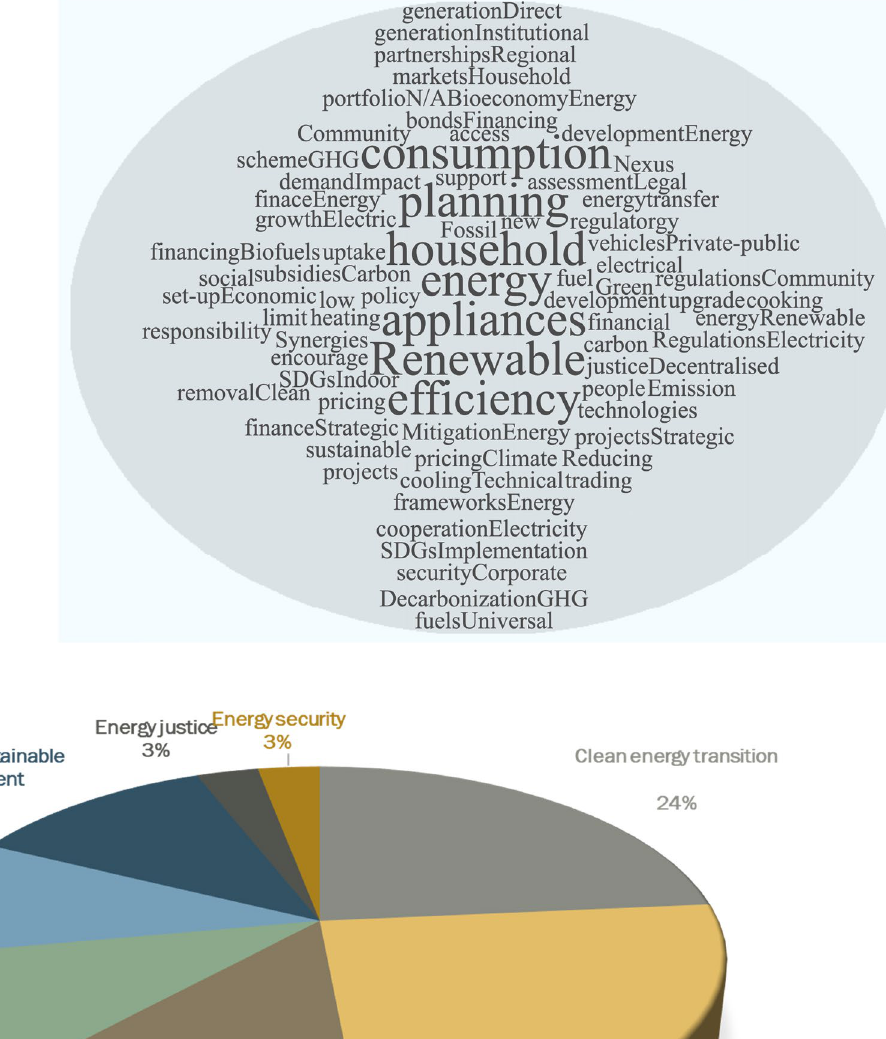
Fig. 8 Policy focus of publica- tions on energy and the SDGs.